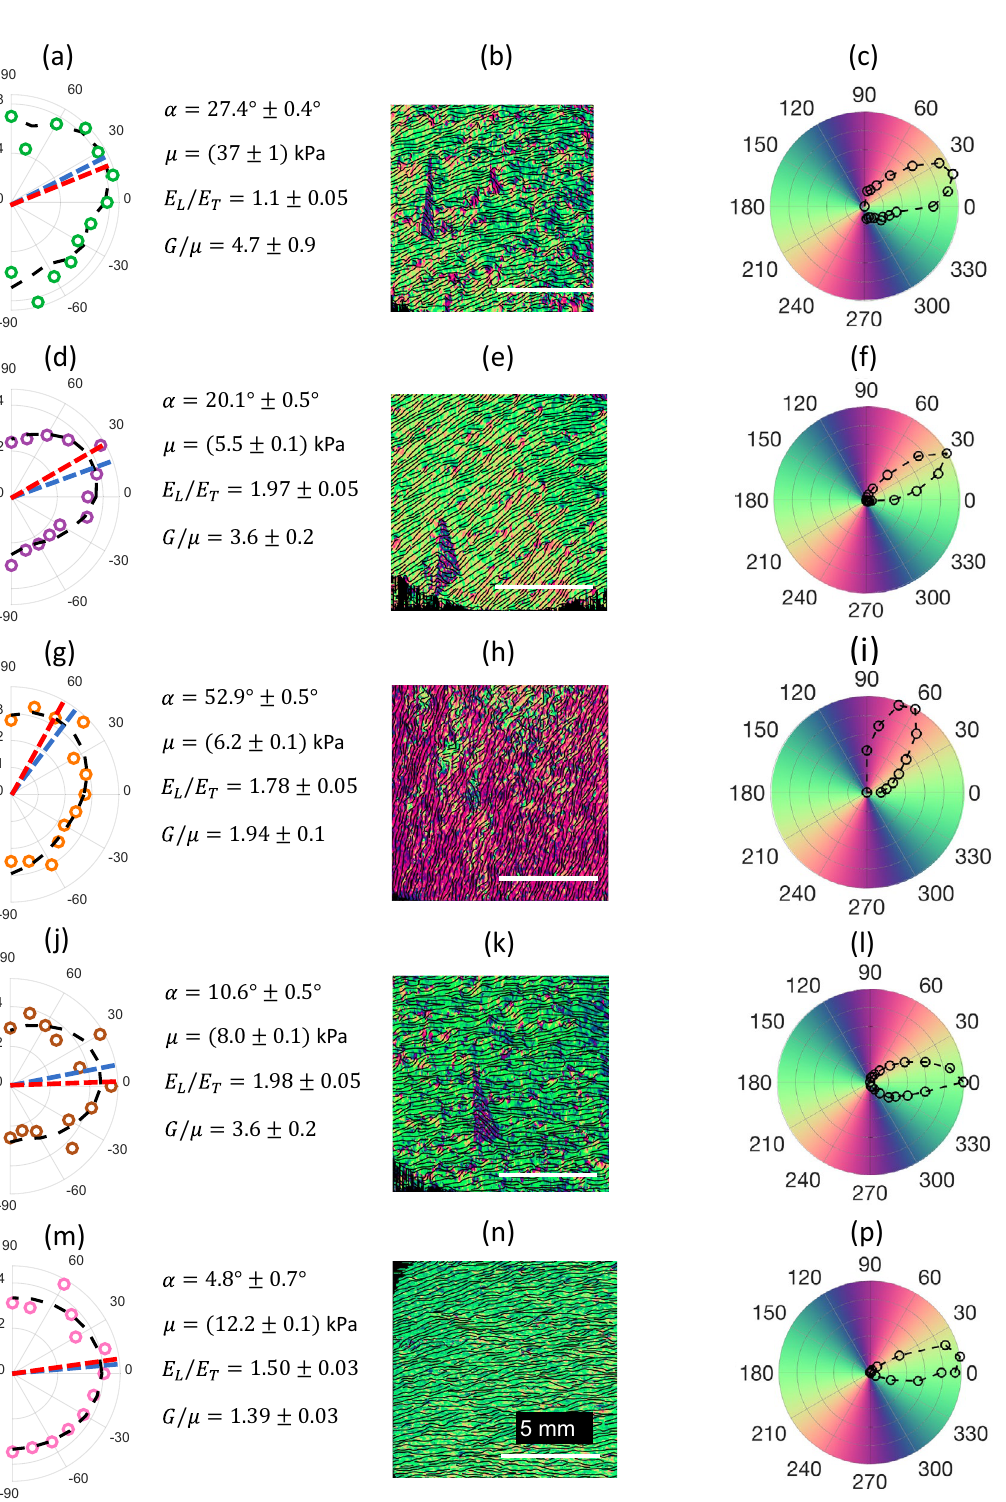
Figure 4. Comparison of AμT-OCE with PS-OCT measurements for all 5 human subjects. Left column (panels ( a ), ( d ), ( g ), ( j ) and ( m )) present AμT-OCE measurements of mechanical anisotropy in skin in human forearm body sites in vivo. Central column (panels ( b ), ( e ), ( h ), ( k ) and ( n )) show optic axis maps integrated over the dermis obtained with PS-OCT, and the right column (panels ( c ), ( f ), ( i ), ( l ) and ( p )) shows directivity patterns of optical polarization in dermis integrated over the dermis thickness at the same body sites. Both methods reveal a similar symmetry direction for all human subjects. Blue and red dashed lines in the left column correspond to the skin’s symmetry axis determined from AμT-OCE and PS-OCT, respectively. A triangular piece of black tape helped align PS-OCT coordinates relative to AμT-OCE